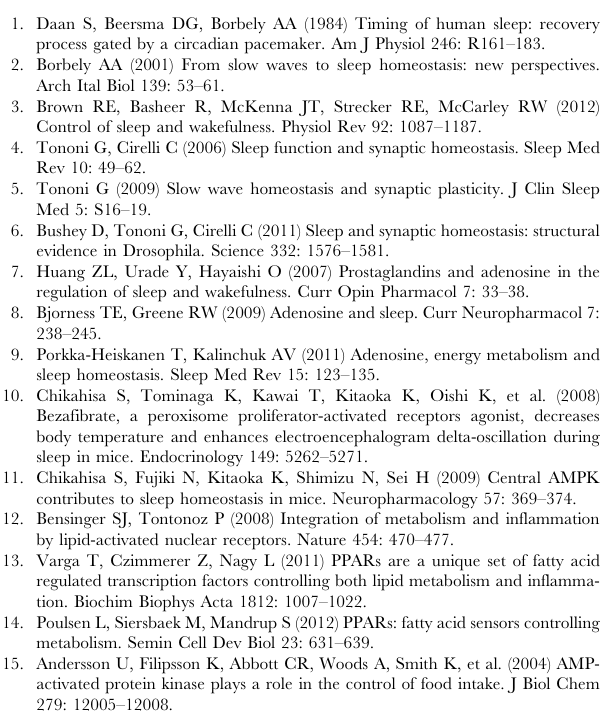
dehydrogenase A (LDHA, encoded by Ldha ), and lactate dehydrogenase B (LDHB, encoded by Ldhb ) in the hypothalamus. Open bars indicate AD mice. Closed bars indicate DR mice. Data represent means 6 SEM (A, B; n =6–7). (PPTX) Figure S8 The protein levels of AMPK a , p-AMPK a , and p- AMPK a /AMPK a ratio in the hypothalamus (A–D) and cortex (E–H). Open bars indicate AD mice. Closed bars indicate DR mice. Data represent means 6 SEM (A–H; n = 5). (PPTX) Figure S9 The effect of 6-hour sleep deprivation on the mRNA expression of Ppar a , Ppar b , and Ppar c in mouse brain. Open bars indicate control (Con) mice. Closed bars indicate sleep-deprived (SD) mice. Data represent means 6 SEM (n= 6). *p , 0.05 indicates a significant difference. (PPTX) Figure S10 Body weight at adulthood in offspring male (aged 32 weeks) and female (aged 28–34 weeks) mice. Open bars indicate AD mice. Closed bars indicate DR mice. Data represent means 6 SEM (n= 14–26). **p , 0.01 indicates a significant difference. (PPTX) Table S1 List of gene-specific TaqMan probes and primers used for real-time